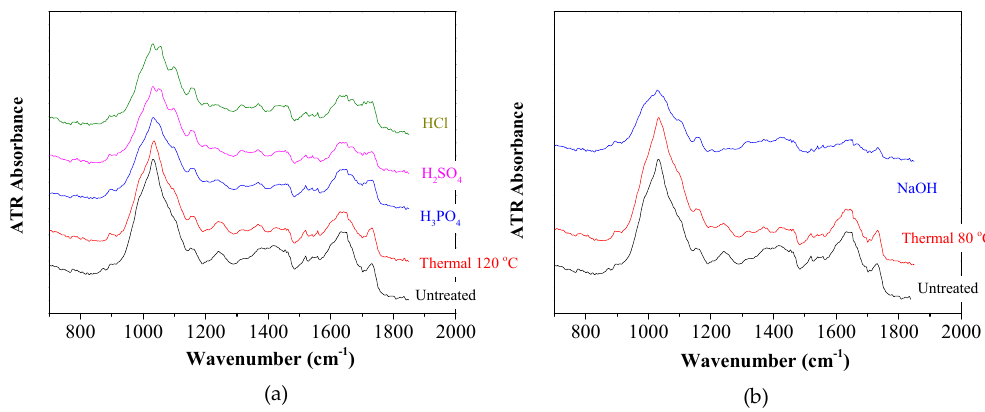
Figure 2. Attenuated Total Reflection (ATR) spectra of raw and ( a ) thermal treatment (TT) at 120 ◦ C for 1 h and acid (H 2 SO 4 , H 3 PO 4 , HCl) pretreatment, at the concentration of 20 g / 100 gTS; ( b ) TT at 80 ◦ C for 24 h and alkali (NaOH) pretreatment at the concentration of 20 g / 100 gTS, respectively.